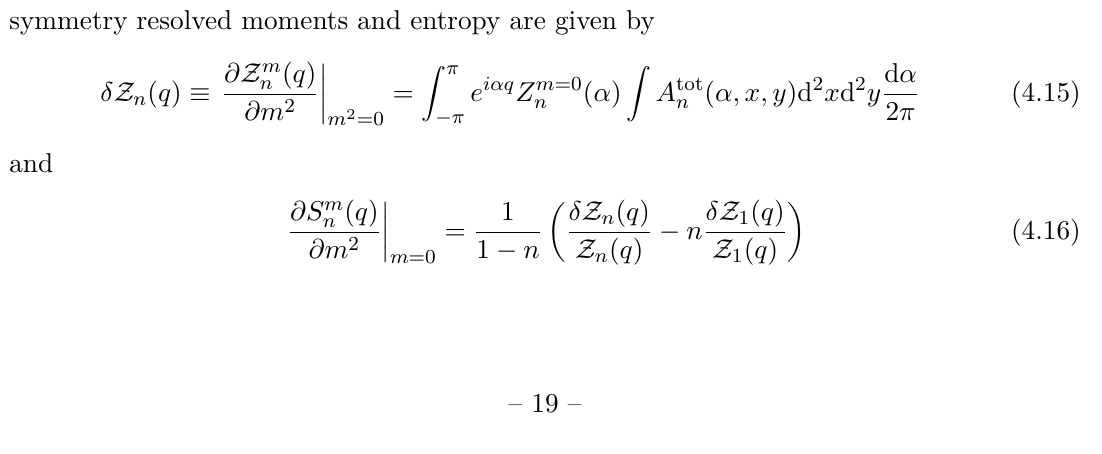
Figure 7 . Mass correction to the symmetry resolved entanglement entropy evaluated for a subsystem of size ‘ = 0 . 5 L and N = 300 total sites. The inverse temperature and the spin sector shown are β = 5 , ν = 2 (left) and β = 1 , ν = 3 (right). We compare the results on the lattice (in orange) and the field theory correction (in blue) in eq.